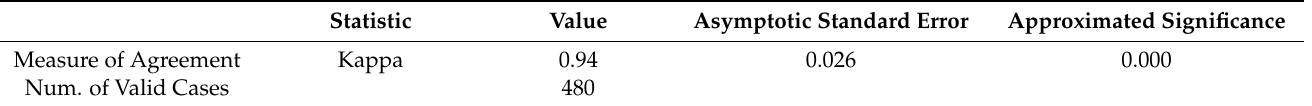
Table 5. Test agreement of RBT and c-ELISA (Cohen’s Kappa test).